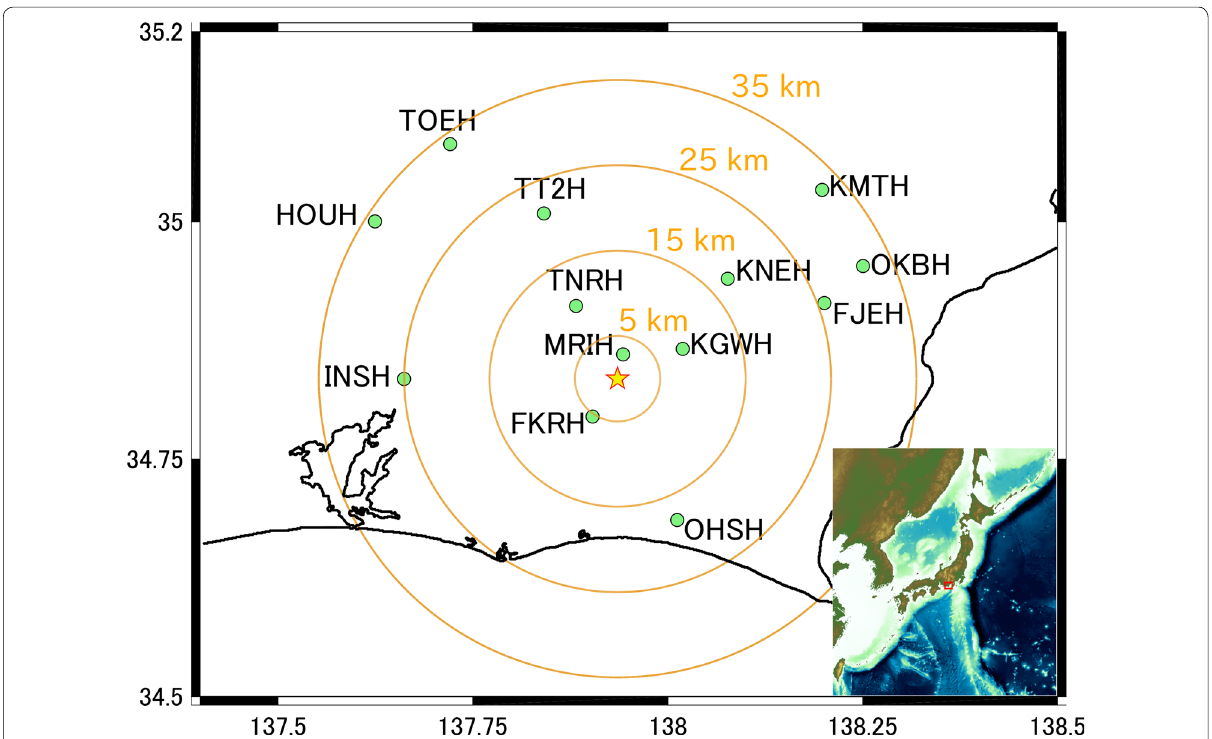
Fig. 1 Location of the ACROSS source and seismic stations. Yellow star denotes the ACROSS source used in this study. Green circles represent the Hi-net stations used in this study. The inset map identifies the area of the main